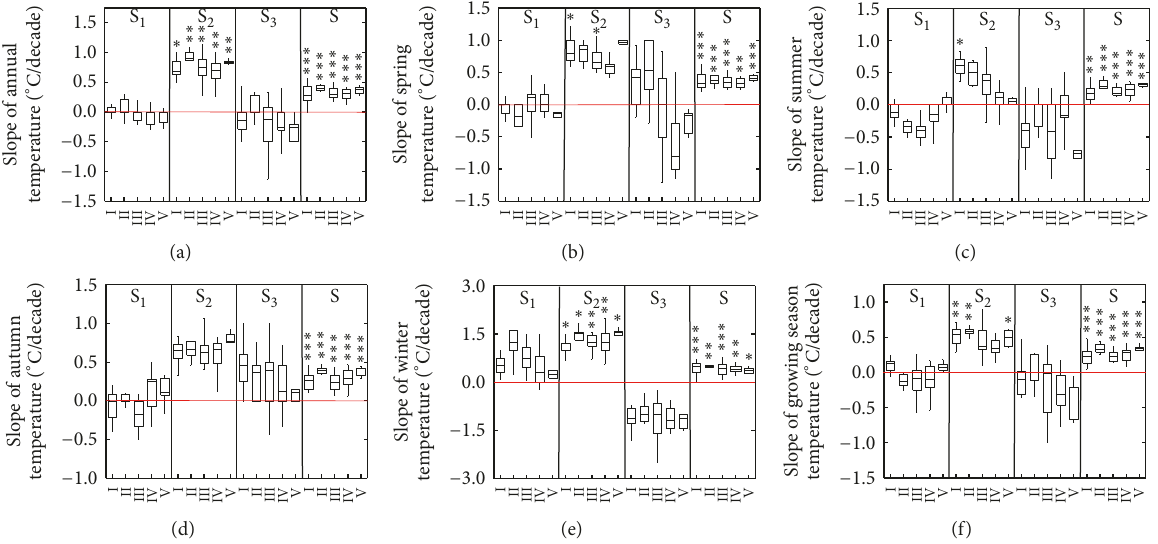
Figure 4: Box-Plot of Slopes for regional average temperature over the five subregions in different stages. (a) Annual, (b) spring, (c) summer, (d) autumn, (e) winter, and (f) growing season. S 1 is 1960–1978, S 2 is 1979–2000, S 3 is 2000–2014, and S is 1960–2014. I is the southwest subregion (SR-I), II is the northwest subregion (SR-II), III is the south-central subregion (SR-III), IV is the east-central subregion (SR-IV), and V is the northeast subregion (SR-V). ∗ ∗ ∗ is 0.001 level of significance, ∗∗ is 0.01 level of significance, and ∗ is 0.05 level of